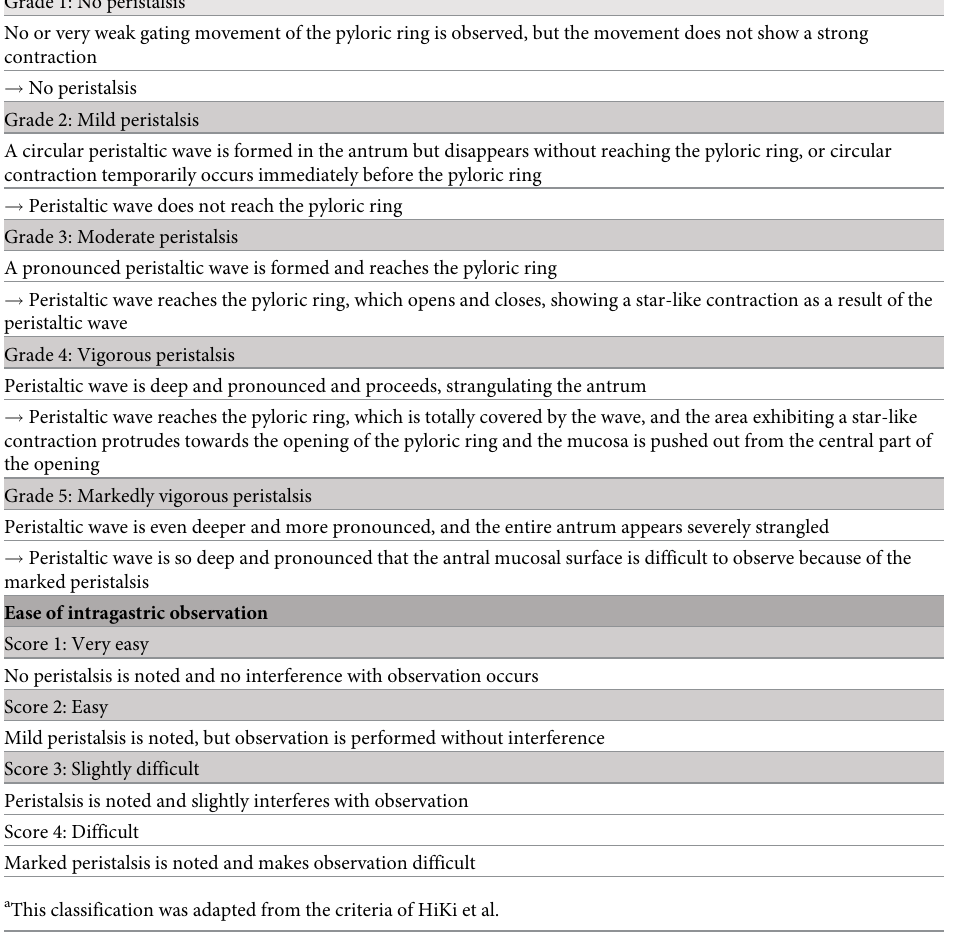
Table 1. Evaluation of gastric peristalsis a . Classification of gastric